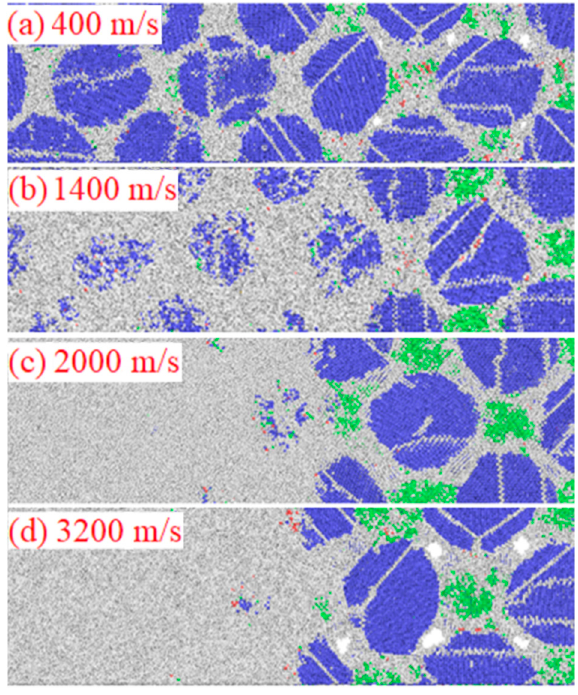
Figure 11. Microstructure of wave fronts at different impact velocities.